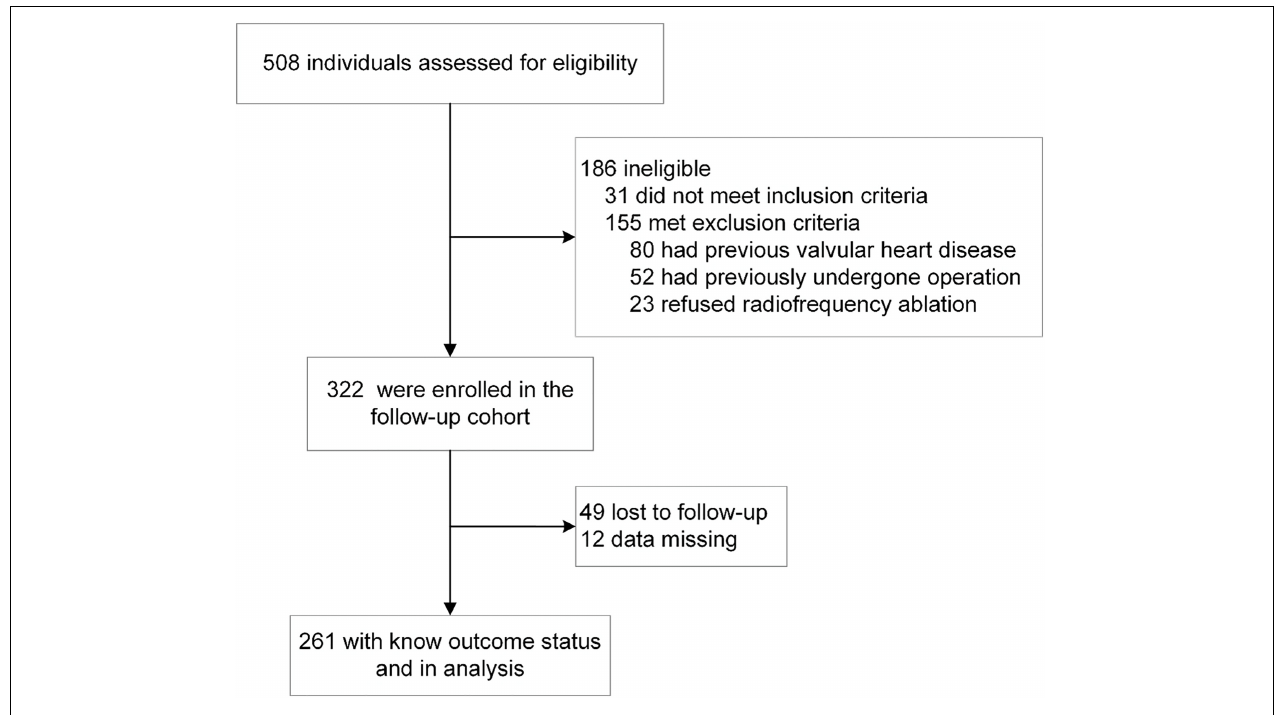
FIGURE 1 | Screening and